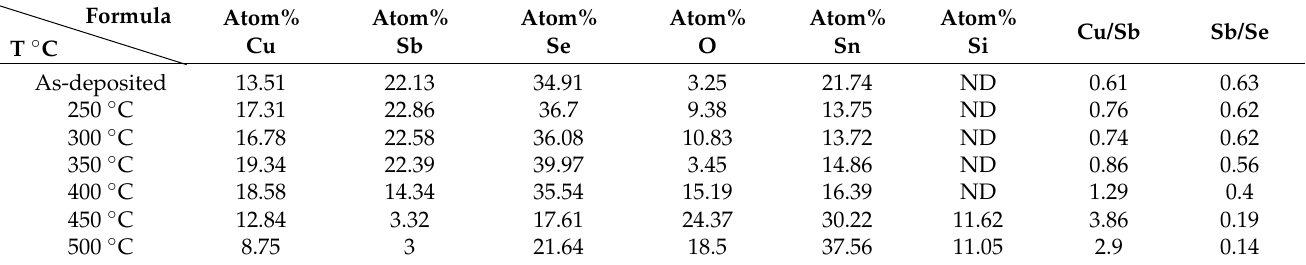
Table 1. EDX measurement of annealed samples at different temperature: atomic % and